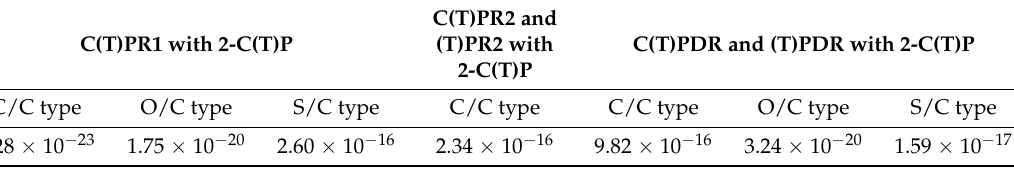
Table 3. Average rate constants calculated at 1000 K for pre-PCTA/PT/DT/DF formation routes from the cross-condensation reactions between C(T)PR1 with 2-C(T)P, between C(T)PR2 and (T)PR2 with 2-C(T)P, and between C(T)PDR and (T)PDR with 2-C(T)P (unit is cm 3 molecule − 1 s − 1